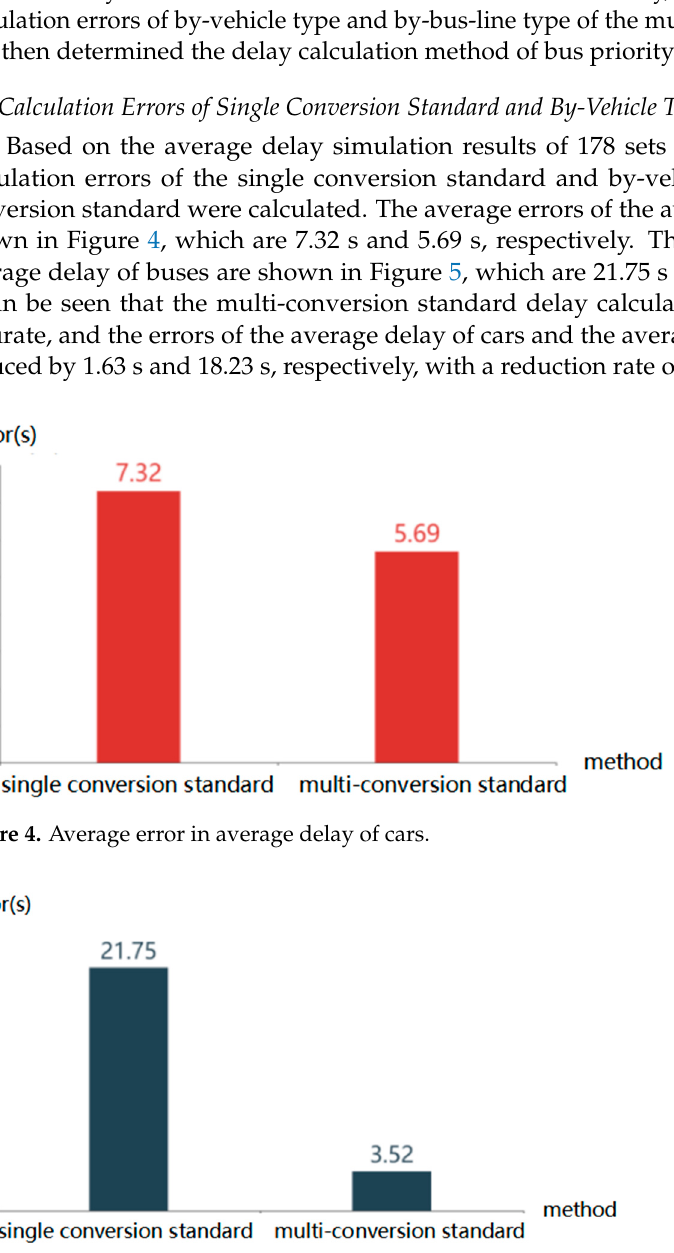
Figure 5. Average error in average delay of buses.